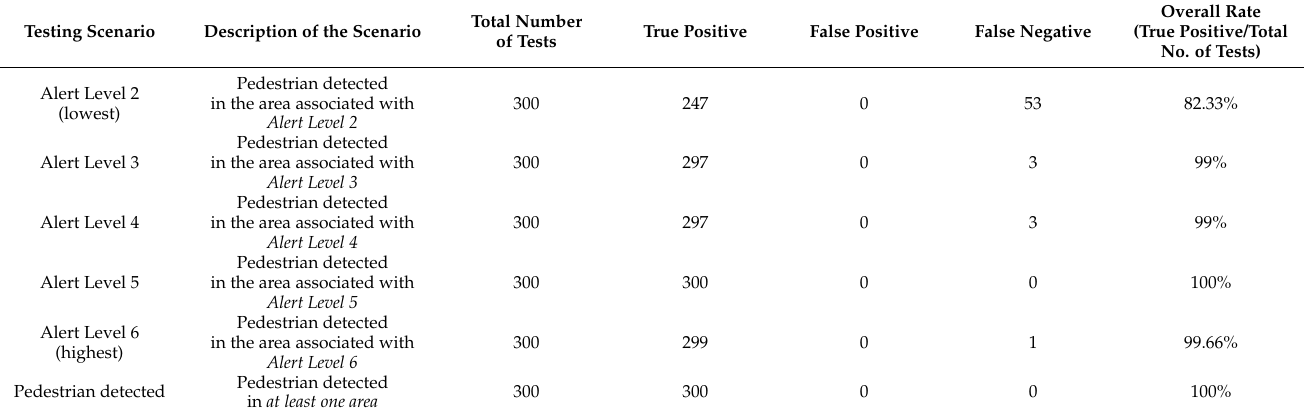
Table 5. Summary of the Pedestrian Presence and Localization System experimental